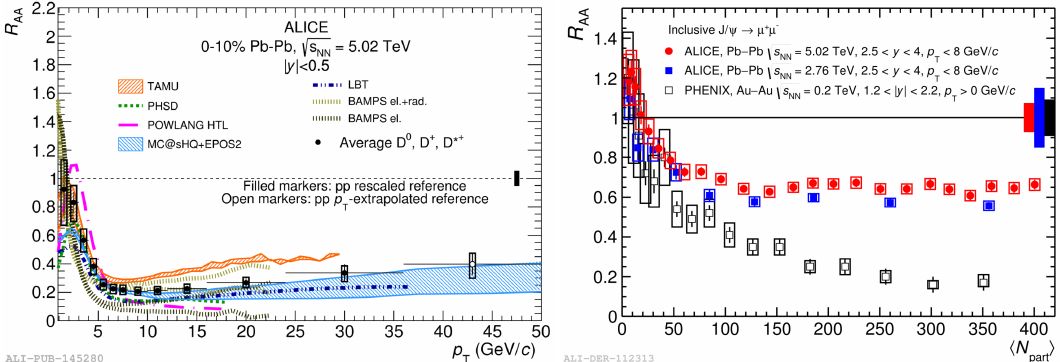
Figure 12. ( Left ) Average R AA for prompt D 0 , D + and D ∗ + in Pb–Pb 0–10% versus p T [29]; and ( Right ) inclusive J/ ψ R AA [33,34] as a function of the number of participating nucleons as measured in √ s NN = 2.76 TeV, compared to PHENIX results [35,36] in Au–Au collisions at Pb–Pb collisions at √ s NN = 200 GeV at forward